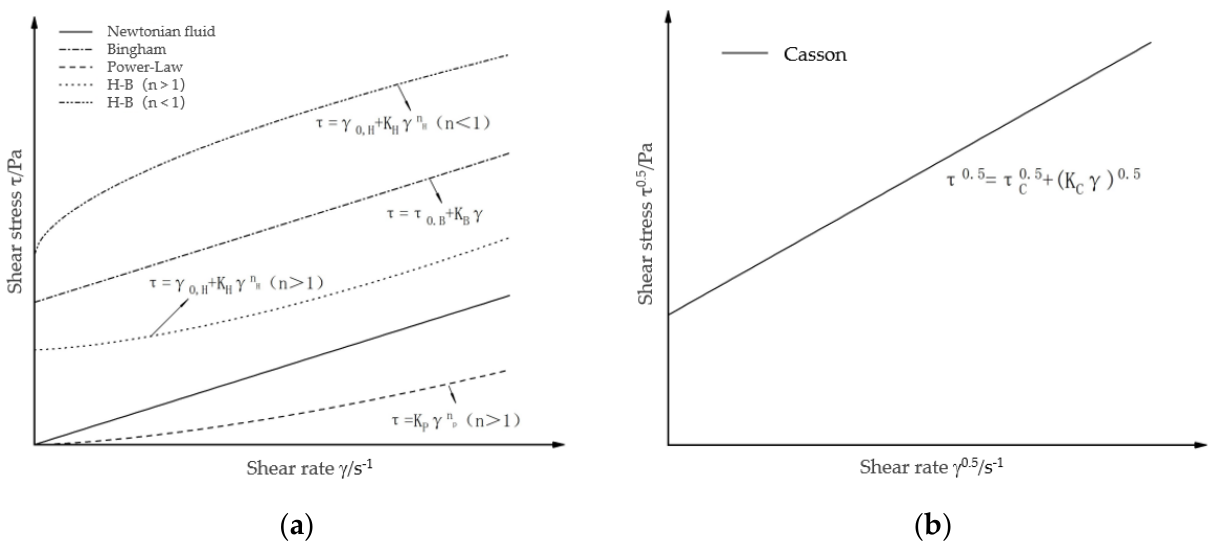
Figure 4. Rheological curves of Newtonian fluid and four non-Newtonian fluid rheological models. ( a ) Newtonian fluid, the Bingham model, the power-law model, and the H–B model; and ( b ) the Casson model.